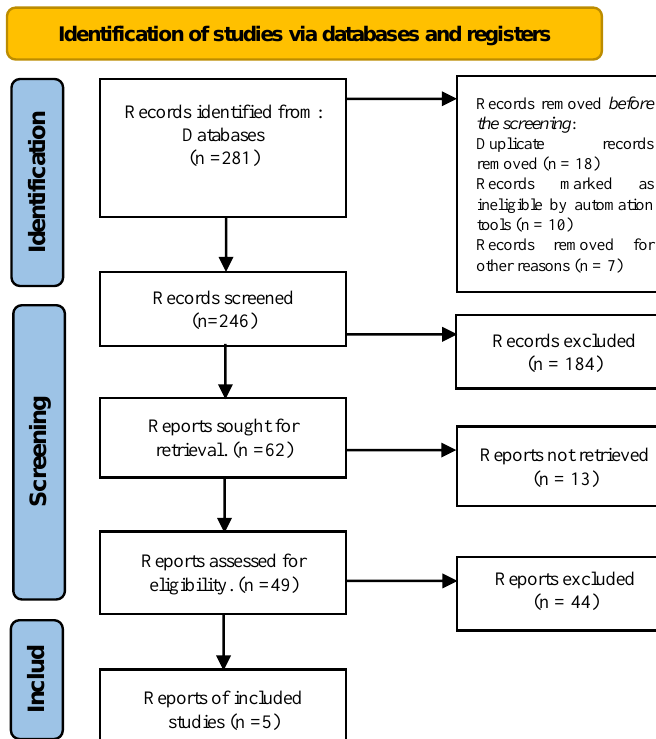
Fig. 1. PRISMA 2020